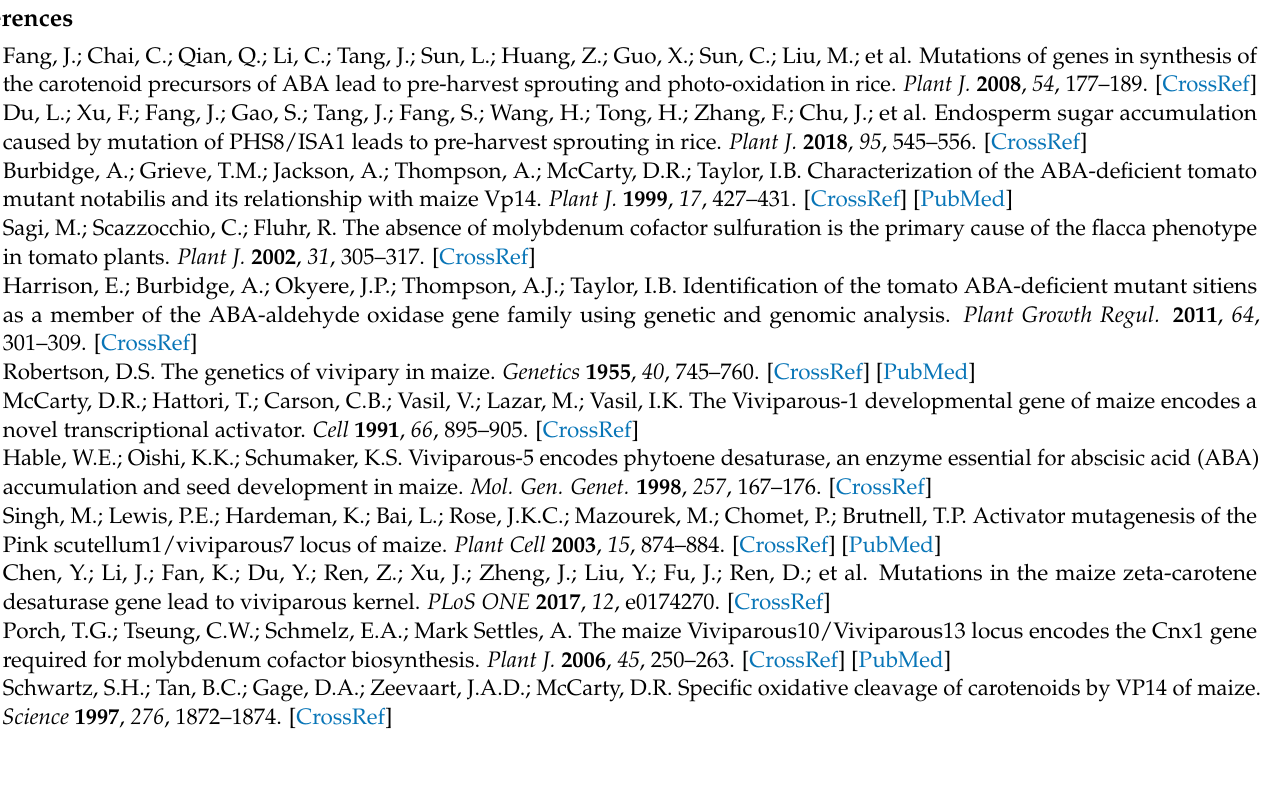
Supplementary Materials: The following are available online at https://www.mdpi.com/article/ 10.3390/plants10112437/s1. Supplementary Figure S1: GO category analysis of DEGs in seven vivipary mutants. Supplementary Figure S2: Gene ontology (GO) category analysis of the specific genes in vivipary mutants. Supplementary Table S1: The summary of RNA-Seq. Supplementary Table S2: Information on the 739 B73 RNA-Seq samples. Supplementary Table S3: Sixty-seven modules obtained following WGCNA analysis. Supplementary Table S4: GO categories analysis of the genes in Module 1. Supplementary Table S5: The commonly up- and downregulated genes in seven vivipary mutants. Supplementary Table S6: The module membership and gene significance of transporters and TFs. Supplementary Table S7: The summary of metabolites. Supplementary Table S8: The relative level of metabolite abscisic acid in vivipary mutants. Supplementary Table S9: The correlation of gene modules with metabolites. Supplementary Table S10: KEGG analysis of the metabolites that had high mean correlation with Module 1. Supplementary Table S11: The connectivity of the tissue samples in the